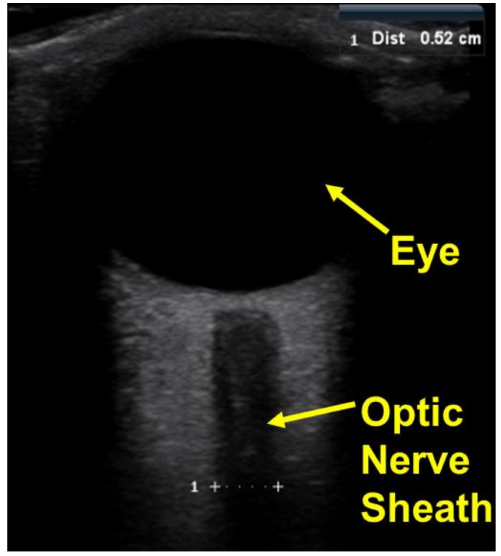
Figure 10. Optic nerve sheath diameter data was obtained from ultrasound imaging of the eye and used to calculate intracranial pressure